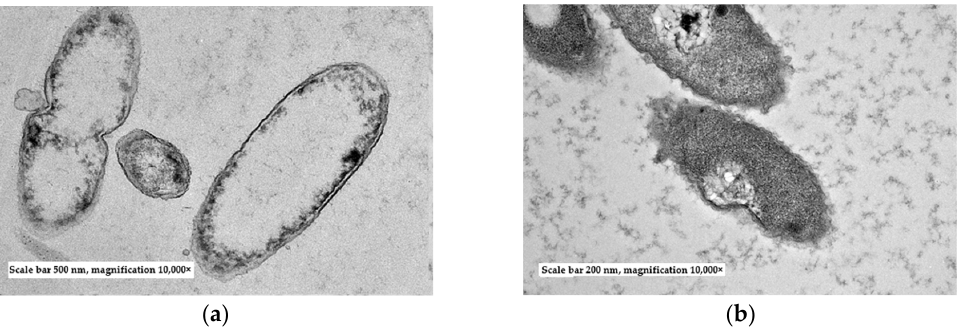
Figure 5. The mechanism of action of GEO against Bg was observed using a transmission electron microscope after being treated for 24 h. ( a ) Bg cells were treated with DMSO in normal rod shape ( b ) Bg cells were treated with GEO (MIC), causing the membrane cell to rupture.